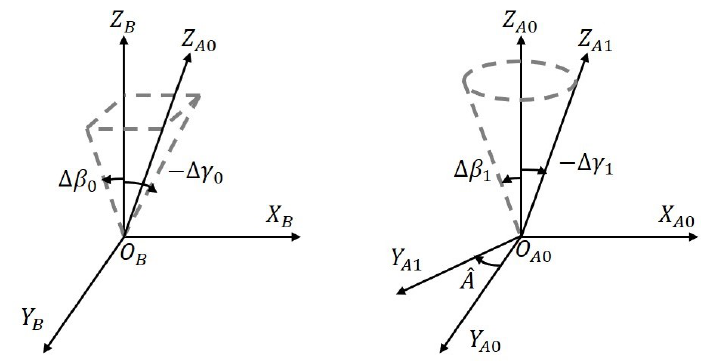
Figure 5. Shafting errors of the azimuth